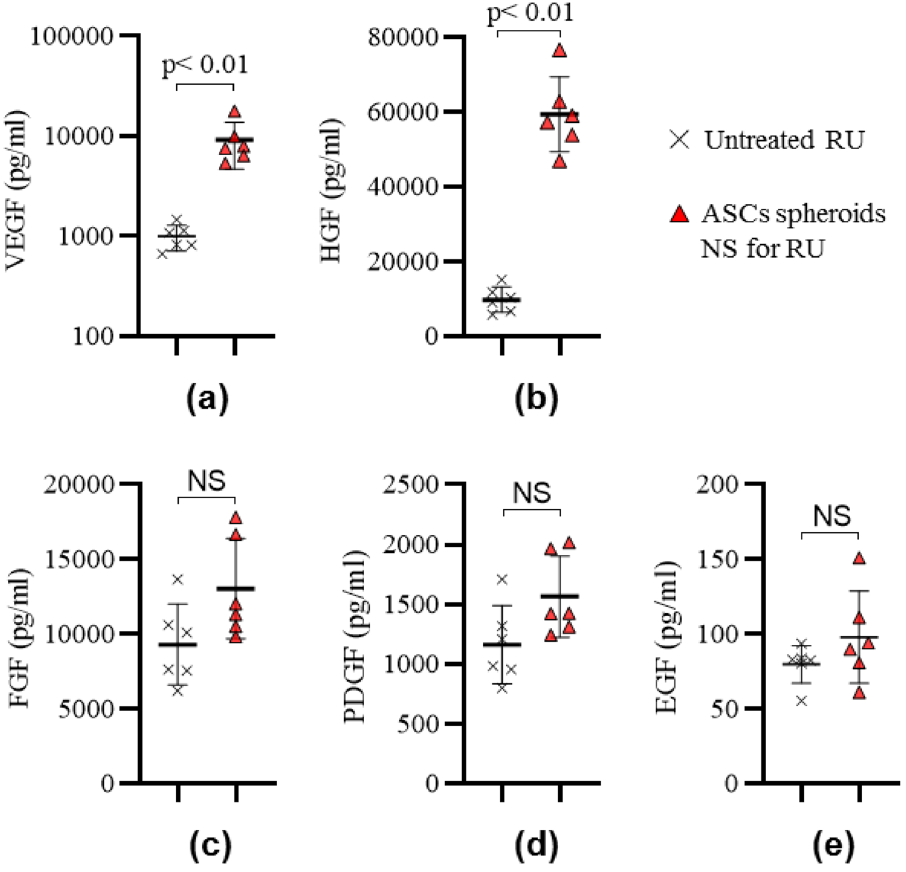
Figure 8. Growth factors expressed in granulation tissues on day 7. ( a ) VEGF, ( b ) HGF, ( c ) FGF, ( d ) PDGF, and ( e ) EGF (n = 6, in each). p < 0.01 or NS (not significant; p >